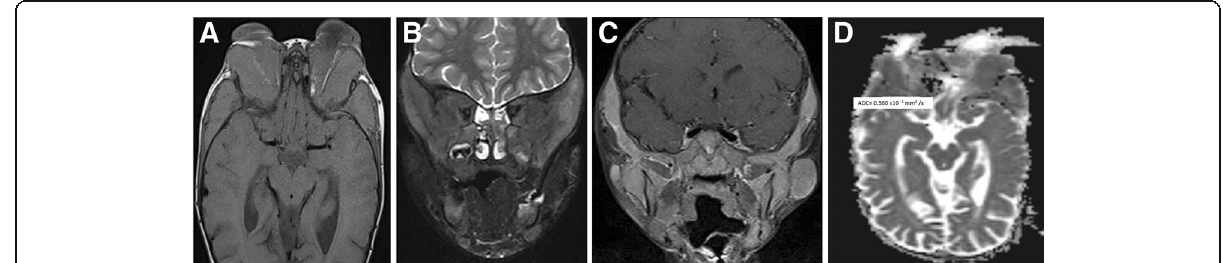
Fig. 1 A 6-year-old boy presented with facial swelling, laboratory investigation, and bone marrow biopsy revealed acute myeloid leukemia. Head MRI showed bilateral rather symmetrical abnormal marrow signal and expansion of both temporal bones. These show low signal on T1WI ( a ) and high signal on STIR ( b ) with appreciable post contrast enhancement ( c ) and diffusion restriction with low ADC value ( d ) that is calculated to be 0.560 × 10 − 3 mm 2 /s. The picture is of diffuse marrow infiltration of both temporal bones